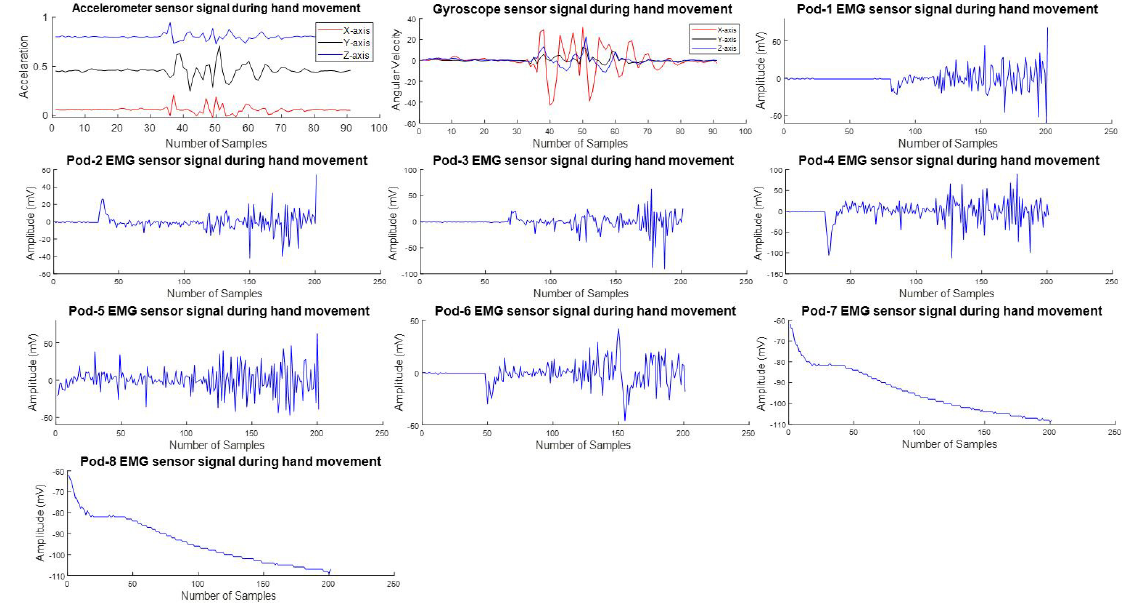
Figure 8. Example of accelerometer, gyroscope and electromyography (EMG) POD signal of double-tap